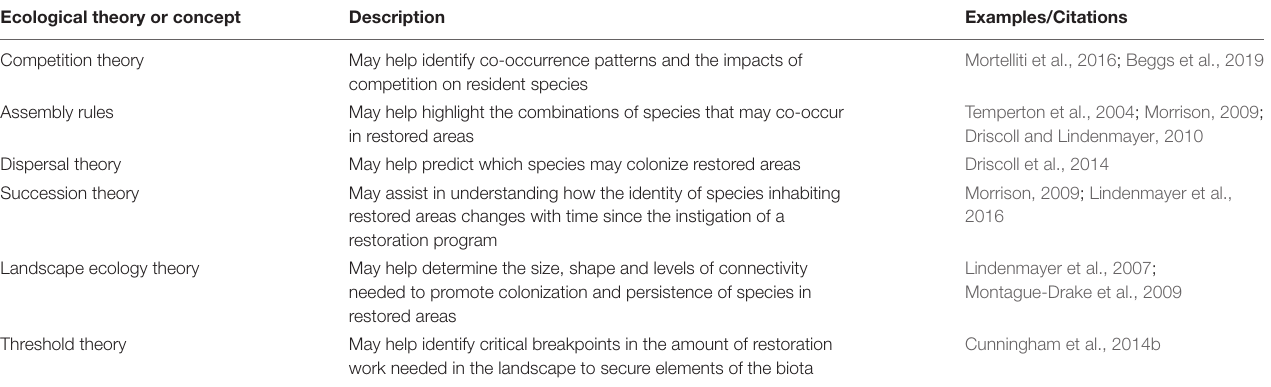
TABLE 1 | Some areas of ecological theory and concepts with broad relevance to restoration management and employed in long-term restoration studies in the temperate woodlands of south-eastern